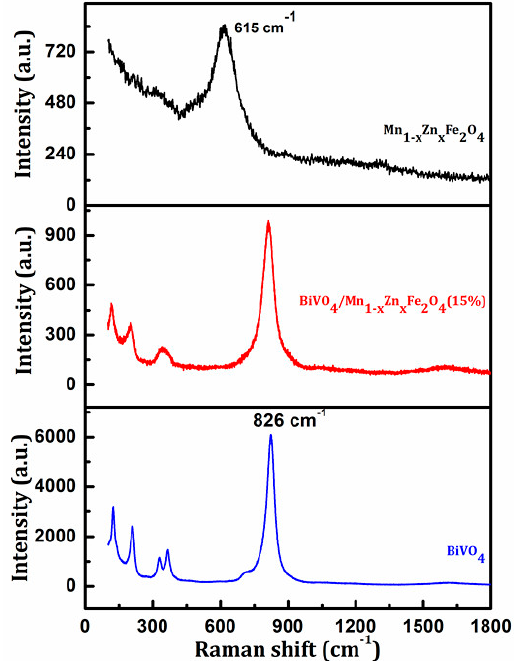
Figure 3. Raman spectra of the prepared samples.